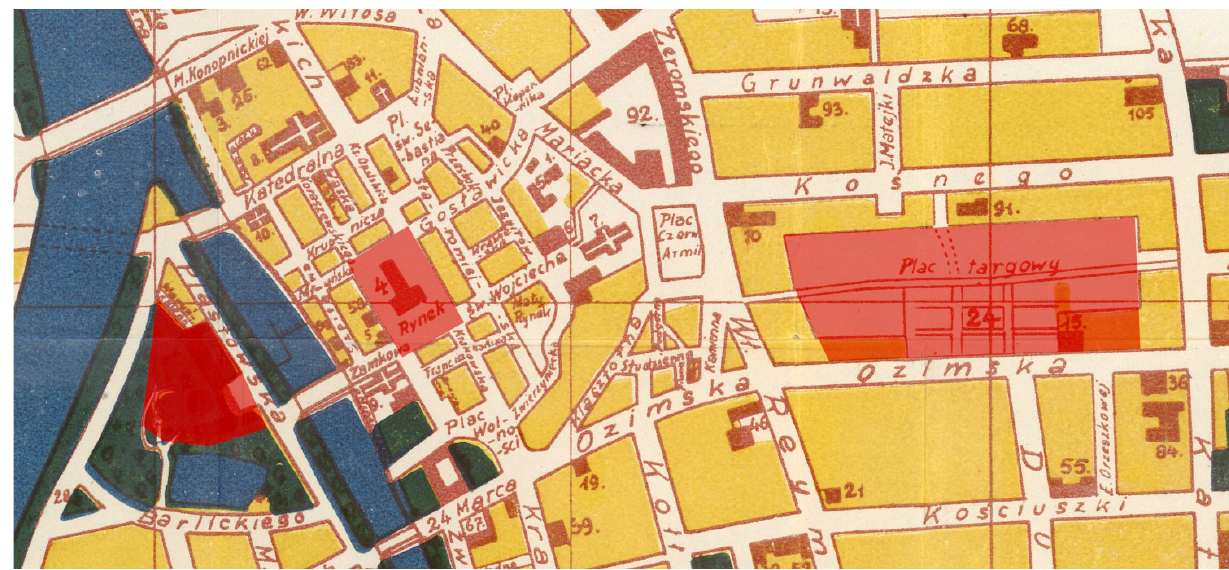
Figure 2. Plan of Opole from 1948 with highlighted areas of Ostrówek (left), Market Square (centre) and Central Square (right). Source: Streer (1948), highlighted areas by the